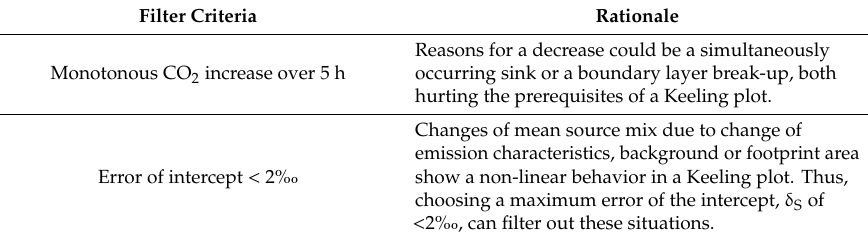
Figure 1. Source signature determination using the Keeling plot. ( a ) The CO 2 mixing ratio (solid line) and δ 13 C (dashed line) of event E7, and ( b ) the Keeling plot for the entire event as shown in ( a ). The y-intercept and coefficient of determination R 2 of the fitted linear regressions following Equation (3) are given in ( b ). Table 1. Filter criteria and rationale based on Vardag et al.